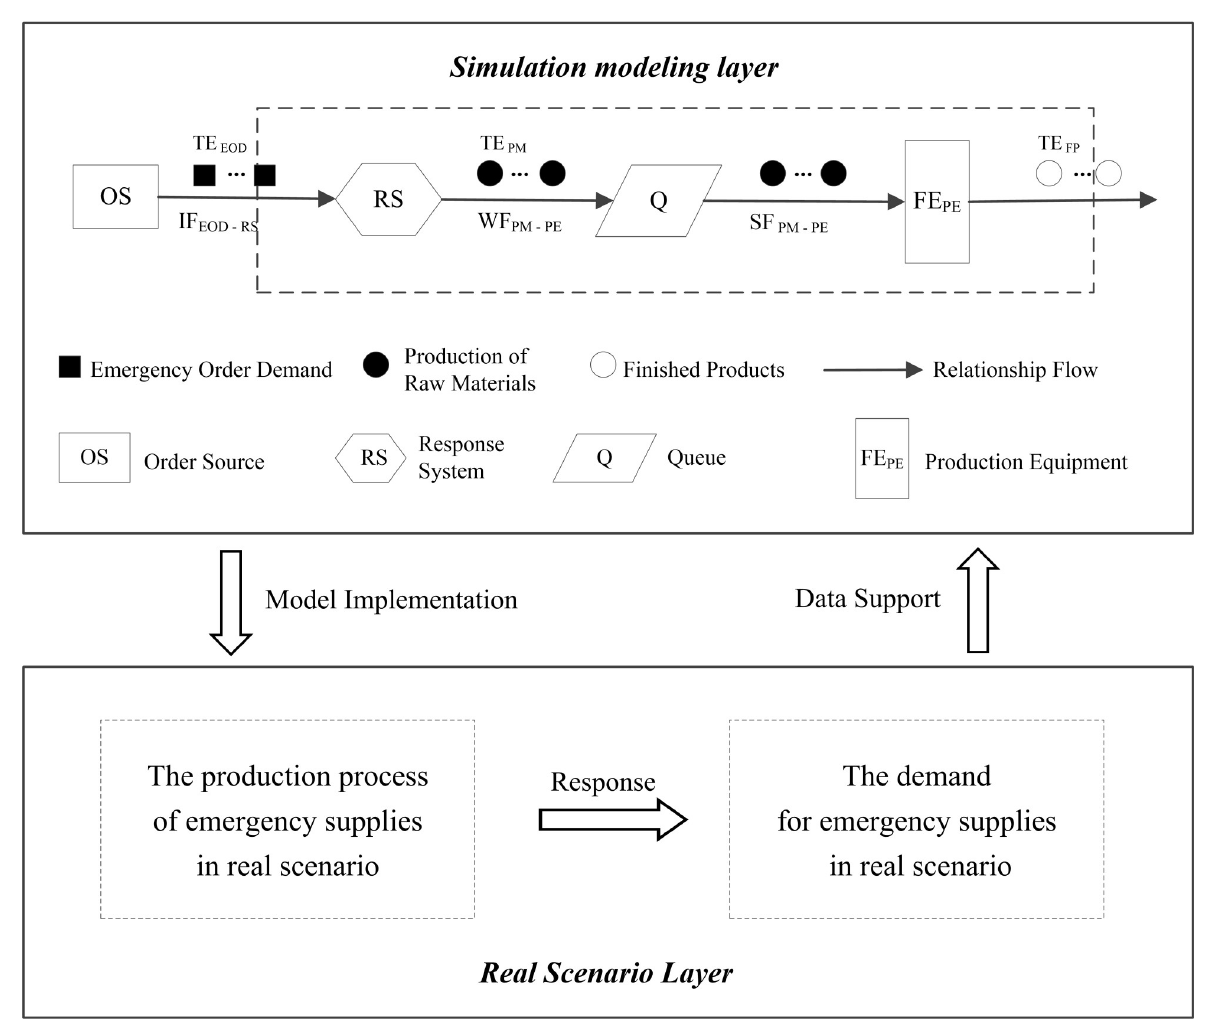
Fig 3. Emergency production process simulation model.